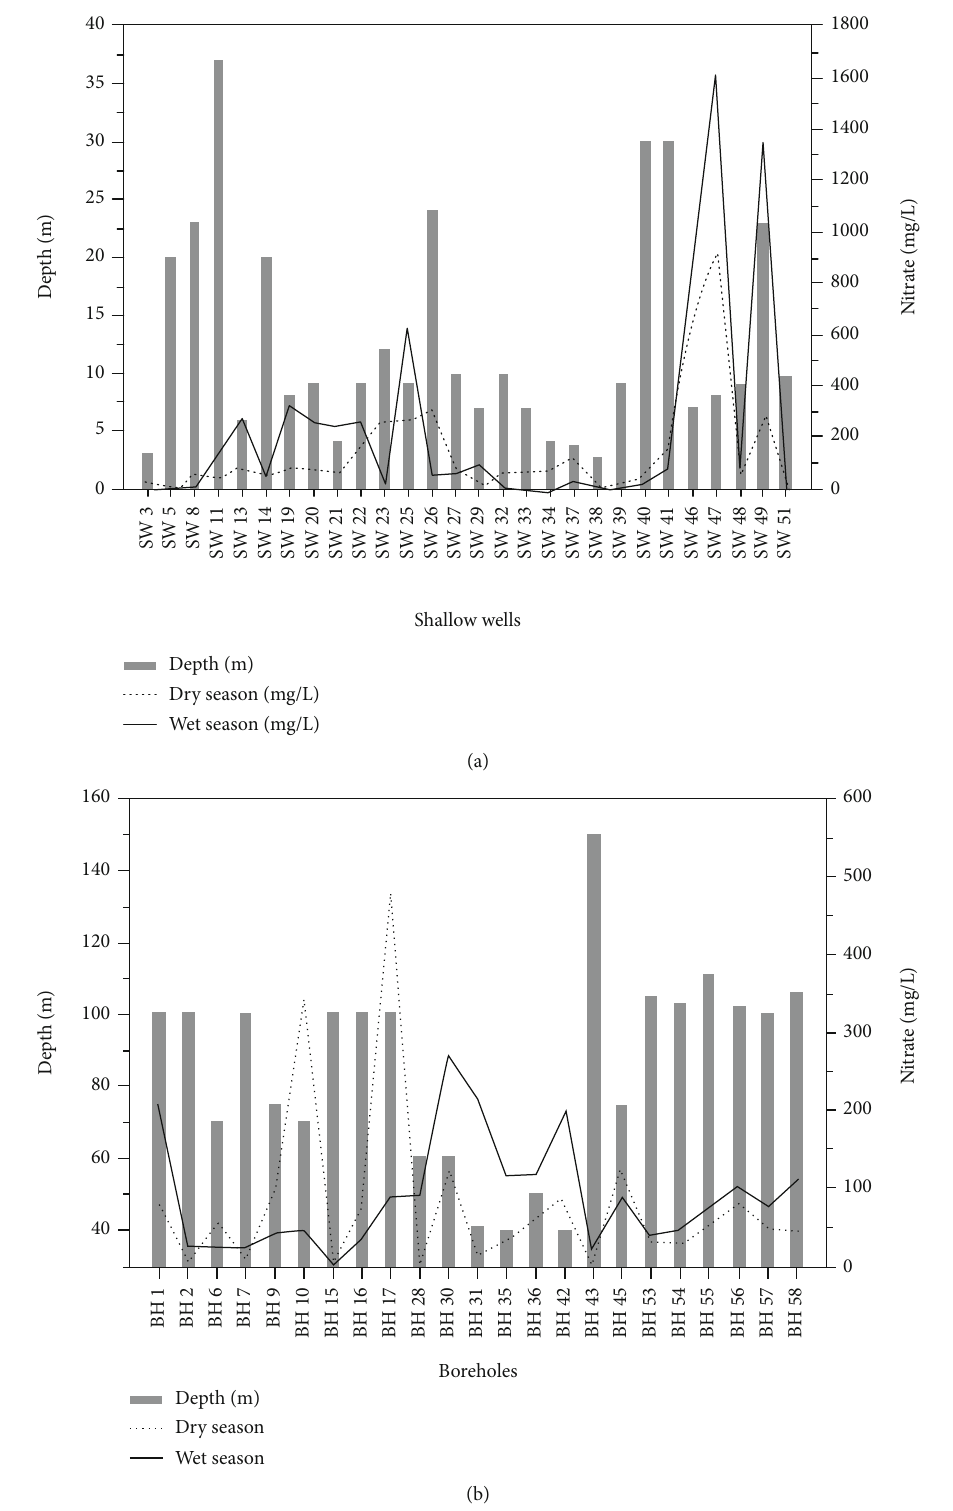
Figure 4: Spatial distribution of nitrate concentrations in relation to depths in (a) shallow wells (SW) and (b) boreholes (BH) during the dry and wet